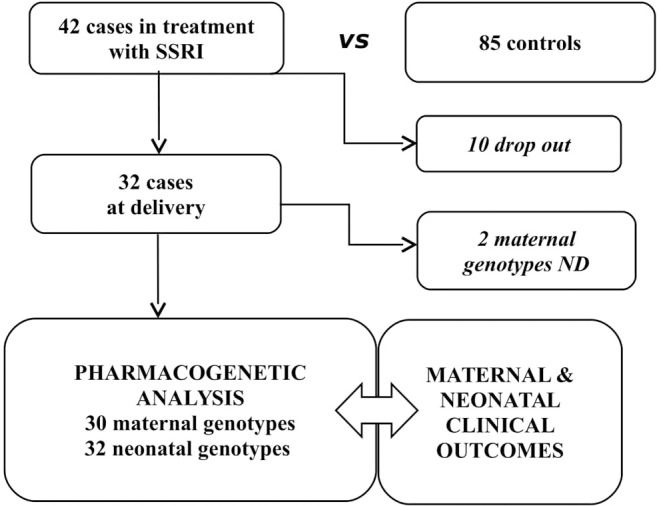
Study population.